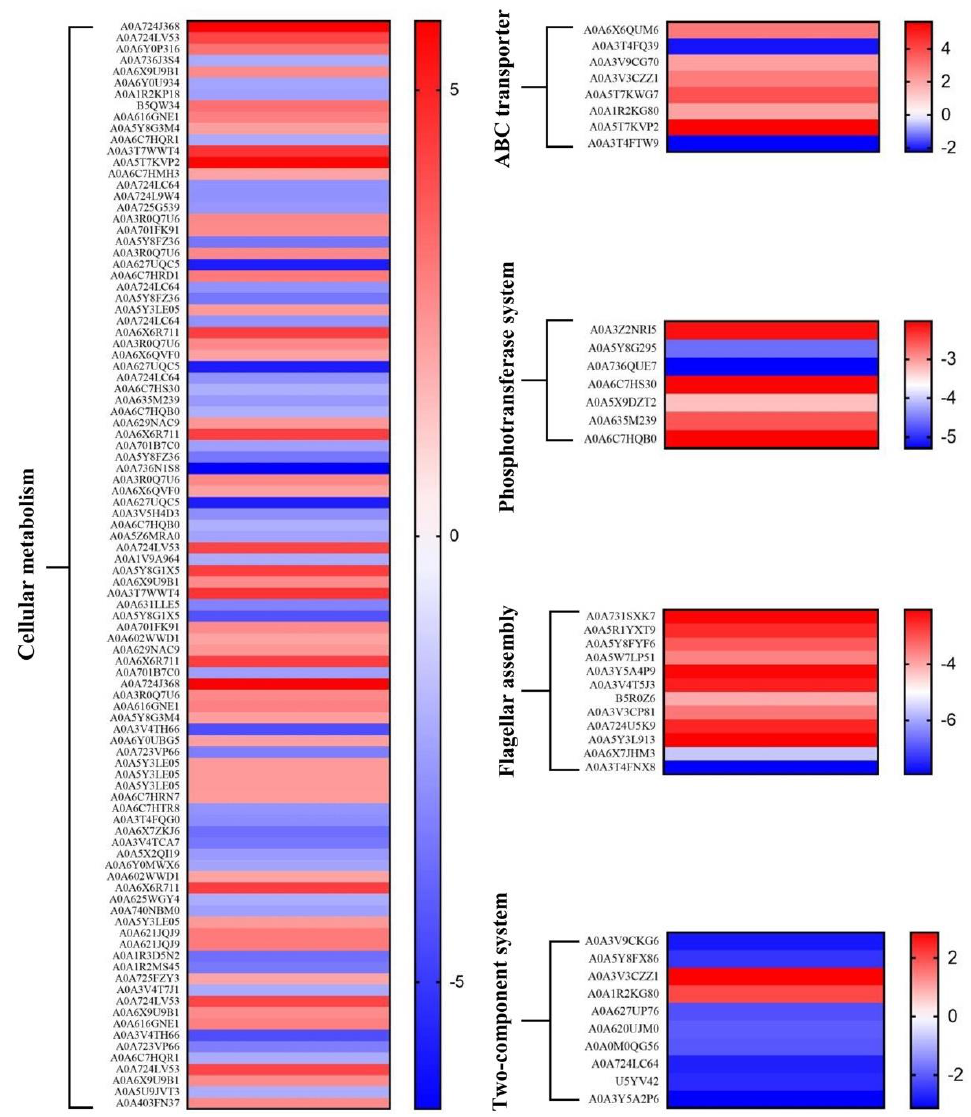
Figure 6. Heat map of differentially abundant proteins in S . Enteritidis during adaptation to 130 ppm sodium hypochlorite.